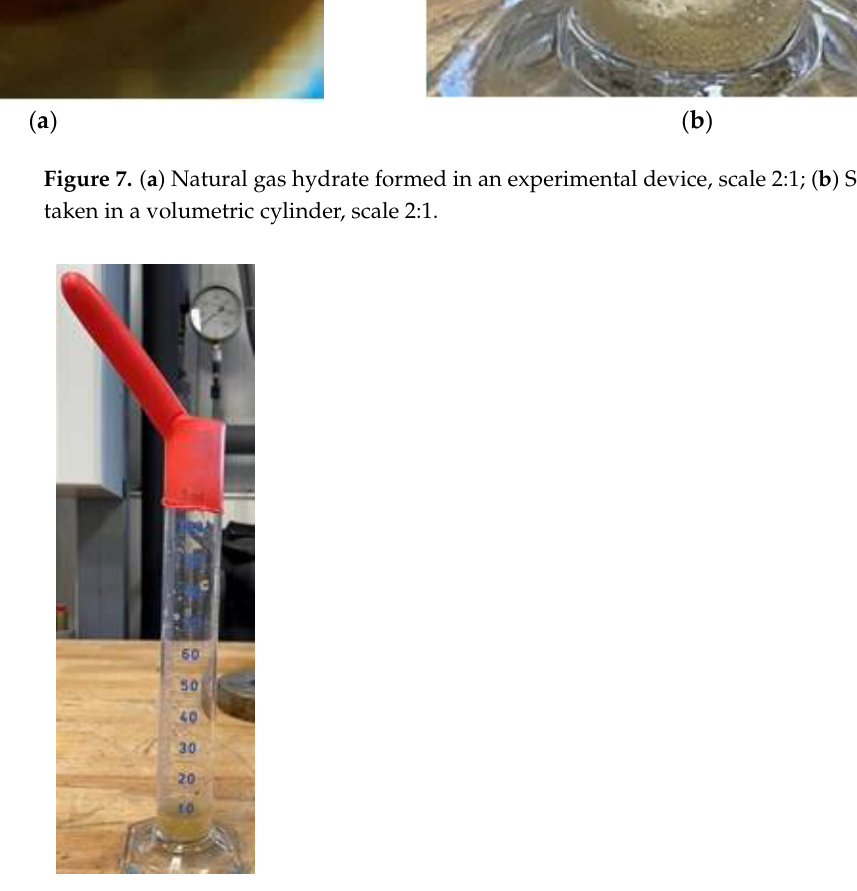
Figure 8. Hydrate exposed to atmospheric pressure and room temperature, scale 1:3.